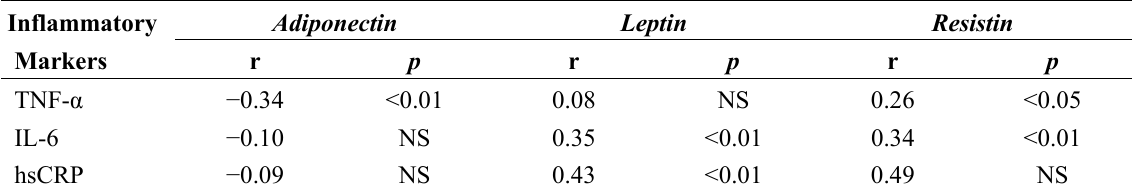
Table 4. Correlation between adipocytokines and inflammatory markers in T2D